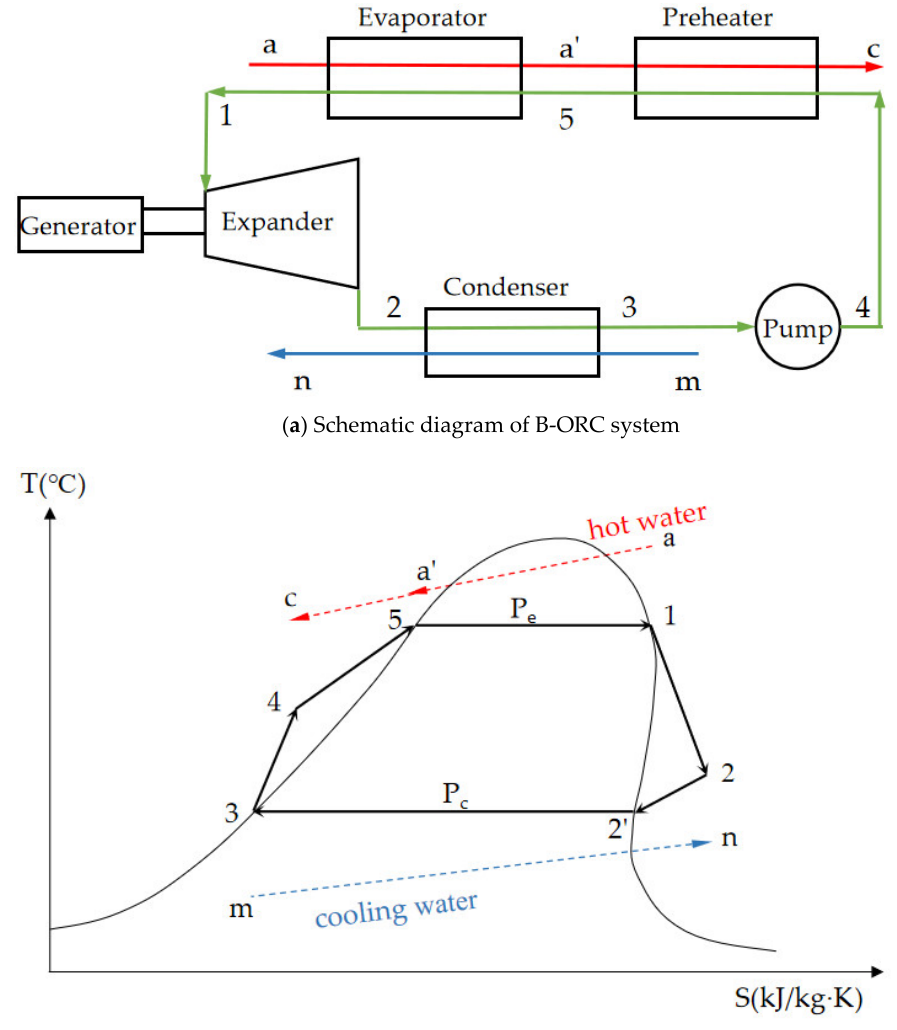
Figure 1. Scheme and the theoretical T - s diagram of B-ORC system.